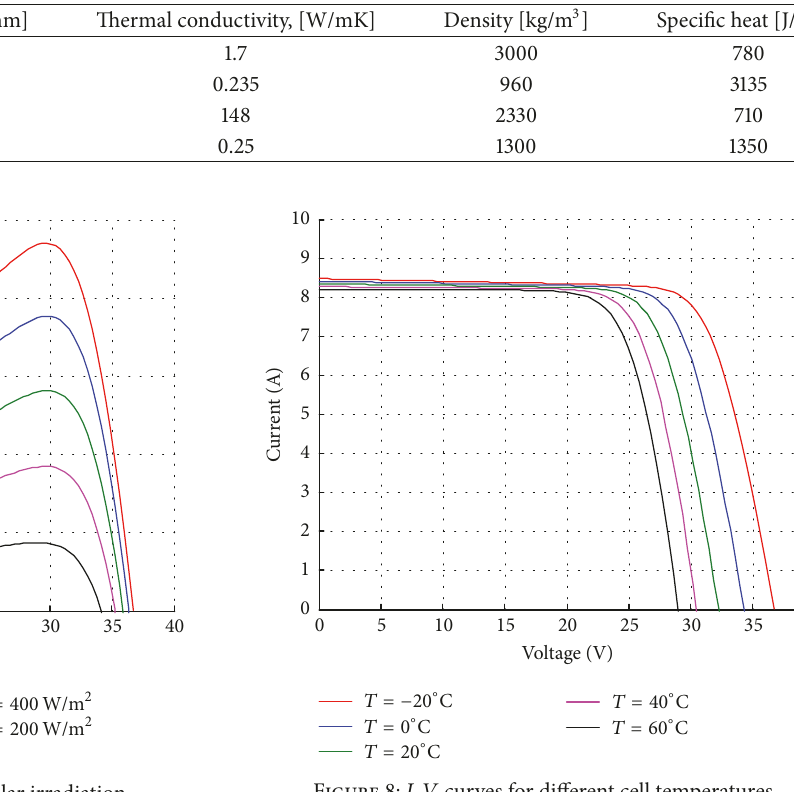
Table 3: Properties of the materials used in AFP 235 module.